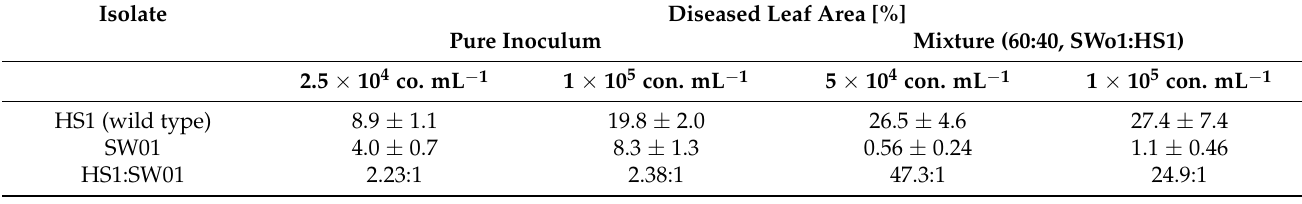
Table 4. Infectivity of Venturia inaequalis isolates HS1 (wild type) and SW01 (melanin-deficient) on apple leaves under greenhouse conditions, 12 d p.i. Mean ± standard error of the mean (n = 6).